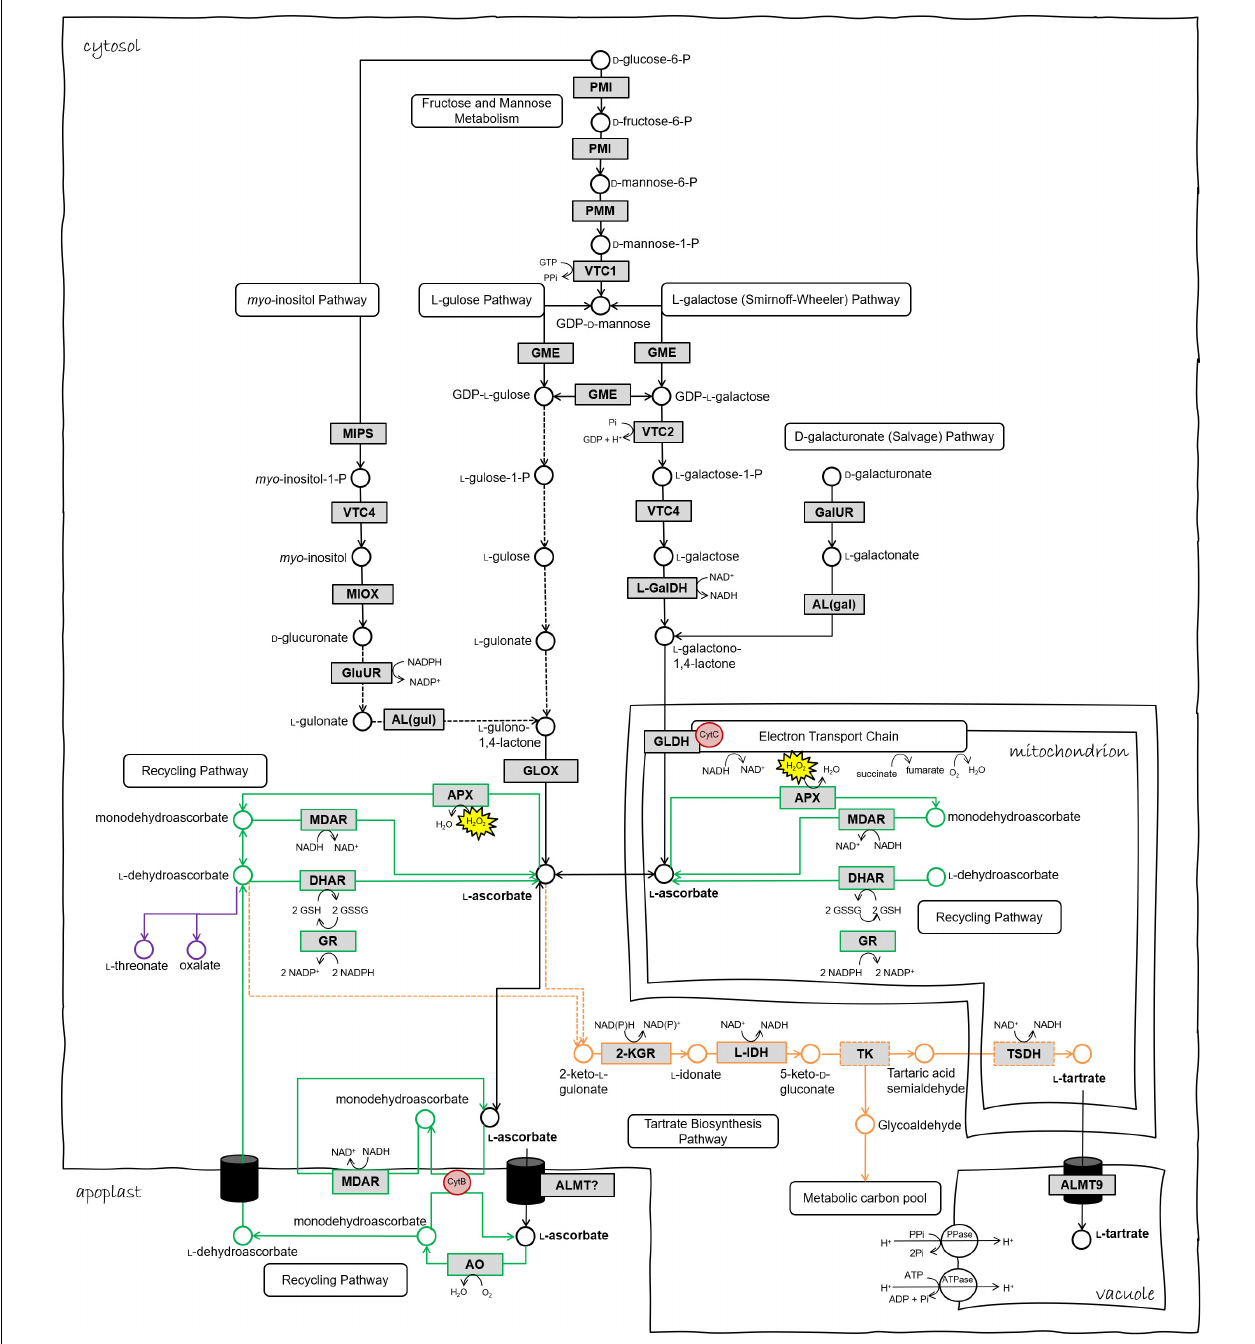
FIGURE 1 | Biosynthetic and redox pathways of ascorbic acid and tartaric acid in the plant cell. Chloroplastic ascorbate redox reactions are omitted from this schematic. Black arrows/metabolites/enzymes represent ascorbate biosynthesis steps. Green represents ascorbate recycling pathways in various cell compartments. Orange represents tartrate biosynthesis pathway. Dashed arrows or boxes indicate hypothetical reactions or enzymes. Enzyme abbreviations as follows. PMI phosphomannose isomerase, PMM phosphomannomutase, VTC1 GDP-D-mannose pyrophosphorylase, GME GDP-D-mannose epimerase, VTC2 GDP-galactose phosphorylase, VTC4 L-galactose-1-phosphate phosphatase, L-GalDH L-galactose dehydrogenase, GLDH L-galactonolactone dehydrogenase, MIPS myo -inositol-3-phosphate synthase, MIOX myo -inositol oxidase, GluUR D-glucuronic acid reductase, AL(gul) aldono-lactonase for L-gulonate, GLOX L-gulonolactone oxidase, GalUR D-galacturonic acid reductase, AL(gal) aldono-lactonase for L-galactonate, MDAR monodehydroascorbate reductase, DHAR dehydroascorbate peroxidase, APX ascorbate peroxidase, GR glutathione reductase, AO ascorbate oxidase, 2KGR 2-ketogulonic acid reductase, L-IDH L-idonate dehydrogenase, TSDH tartaric acid semialdehyde dehydrogenase, TK transketolase, ALMT aluminum-activated malate transporter, cytB Cytochrome B561. Figure adapted from Melino et al. (2009a), Burbidge (2011), and Podgórska et al. (2017).